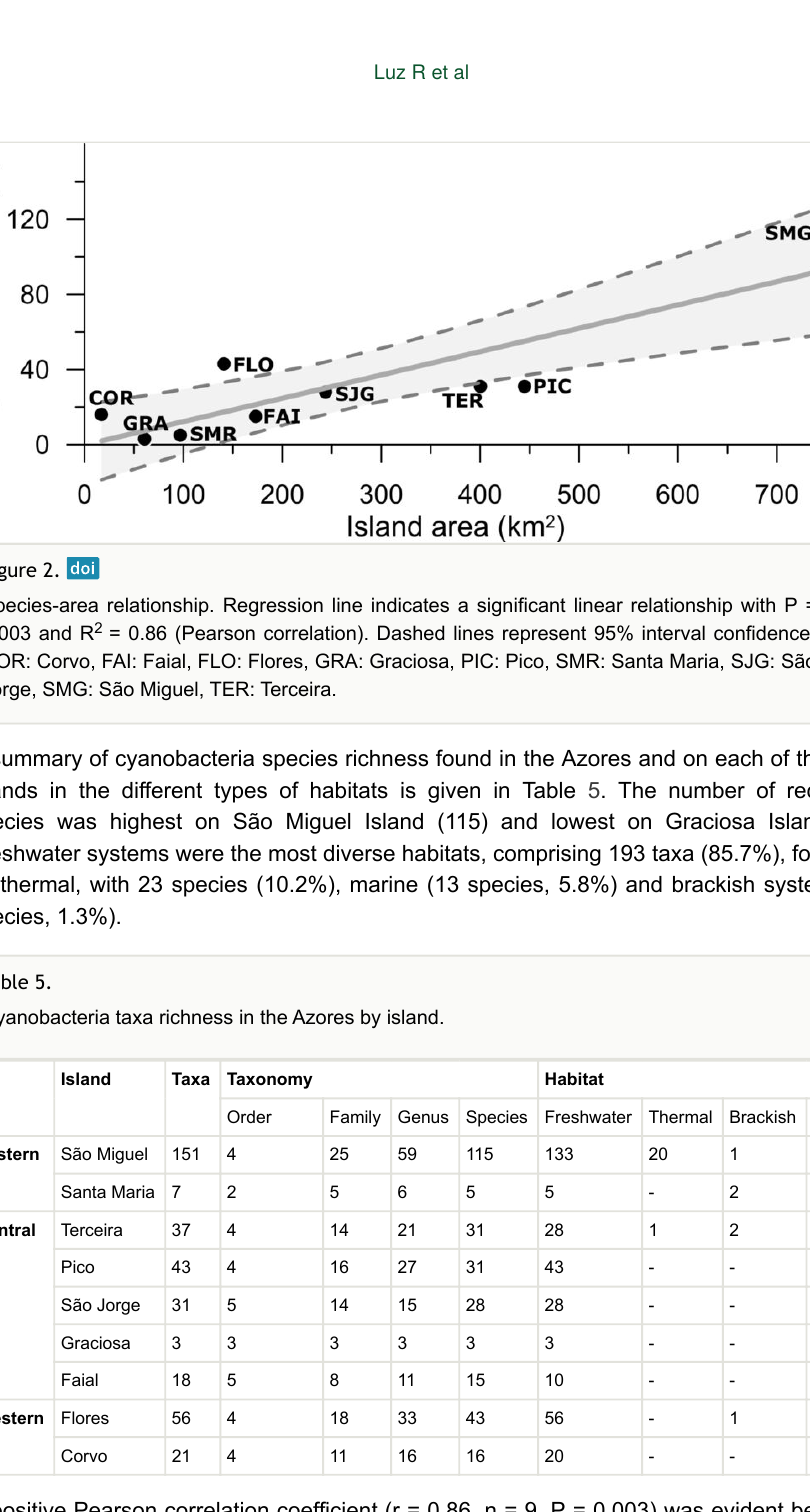
species richness (S) and island area. This correlation is best described by a linear